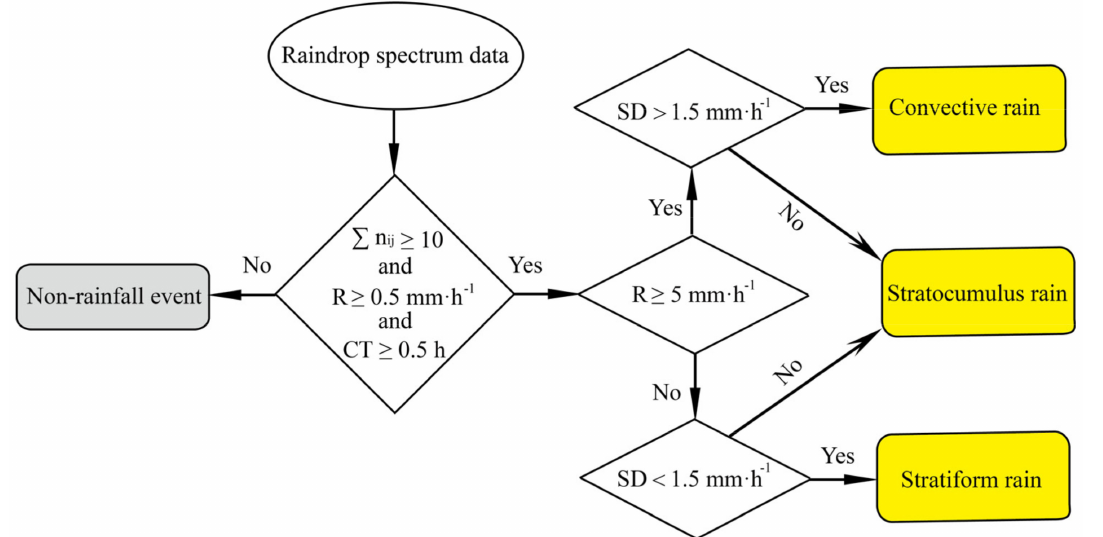
Figure 2. Flow chart of classifying stratiform, convective, stratocumulus rain, and